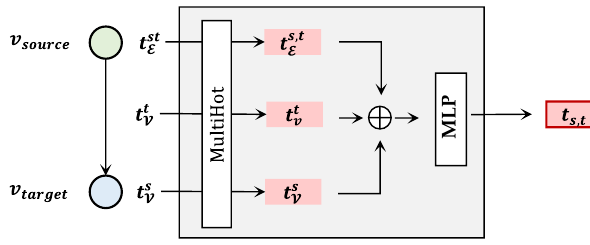
Figure 5. Diagram of the type-scalar embedding module.